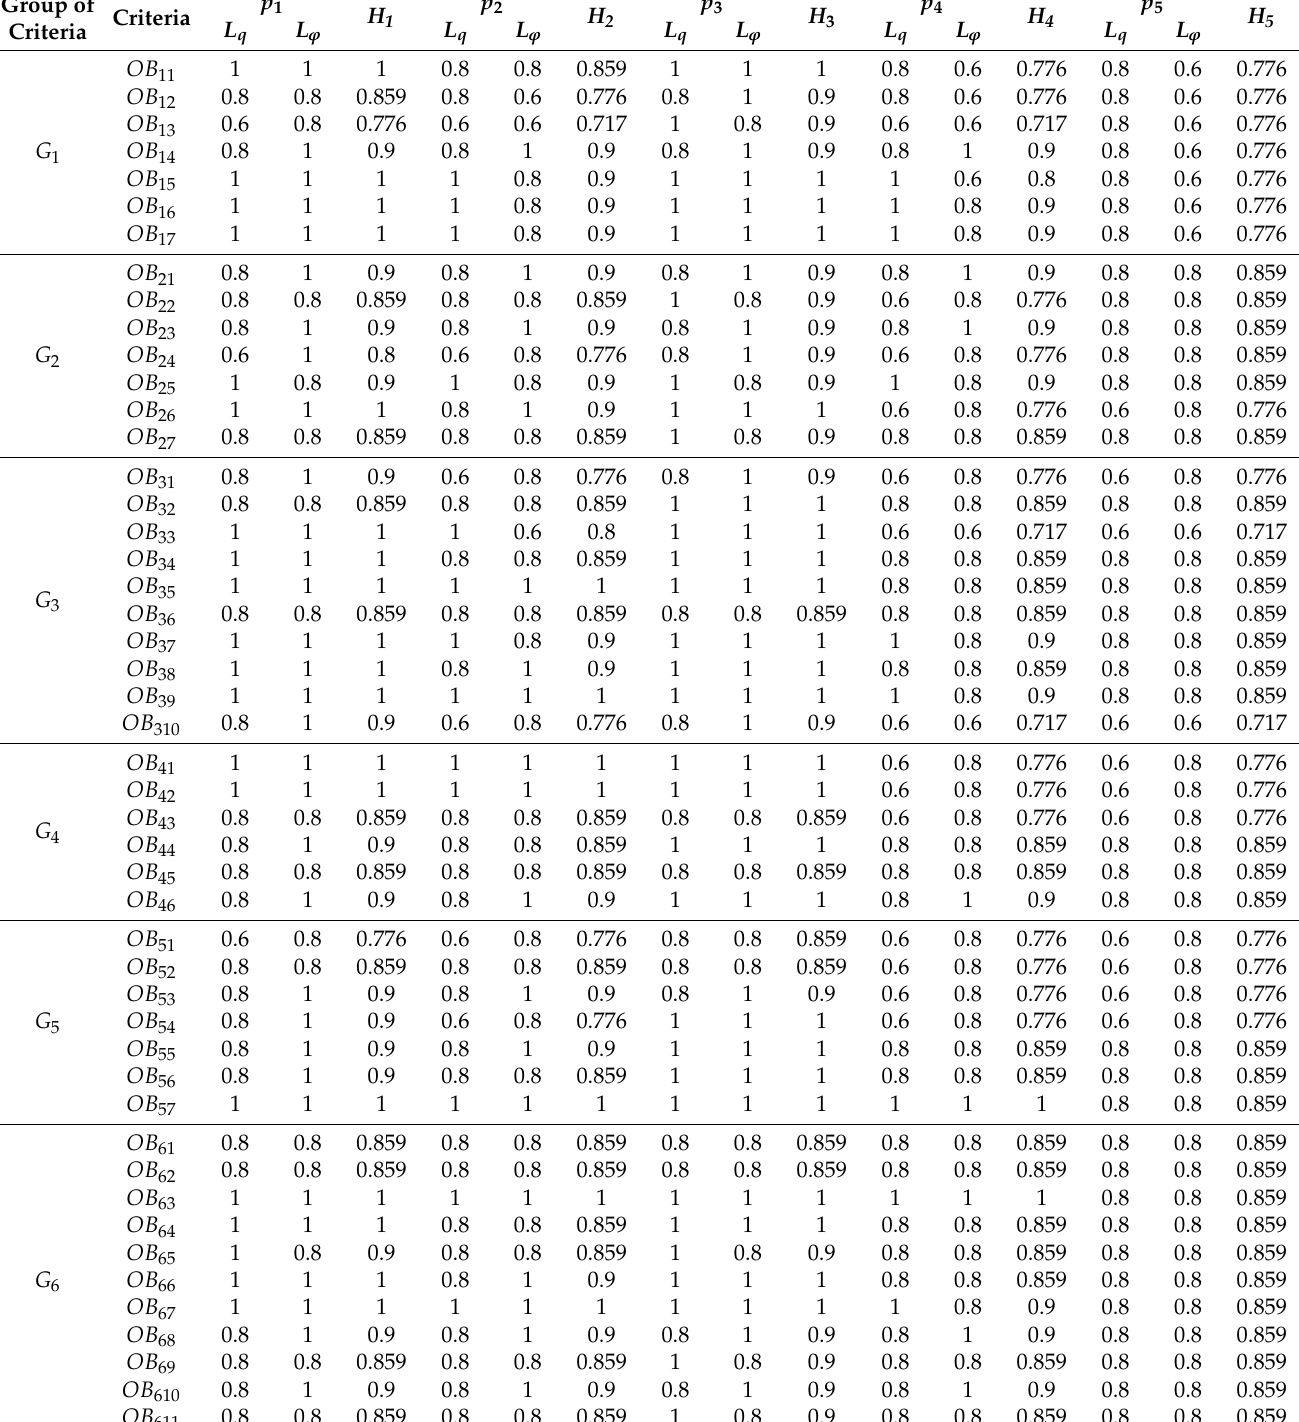
Table 5. Aggregation inputs and results for “observed